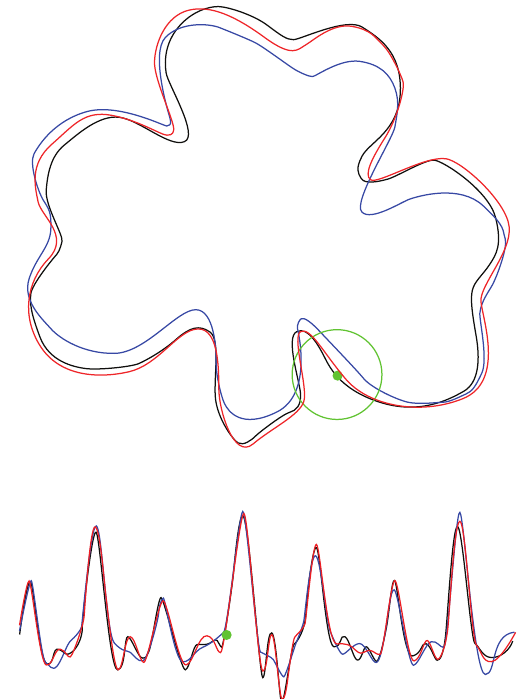
Figure 14: Shamrock reconstruction: comparing the original curve with those found for 𝑚 = 12 and 𝑚 = 18 . Curves for 𝑚 ≥ 20 are visually indistinguishable from the original curve. The shape signatures are given at the